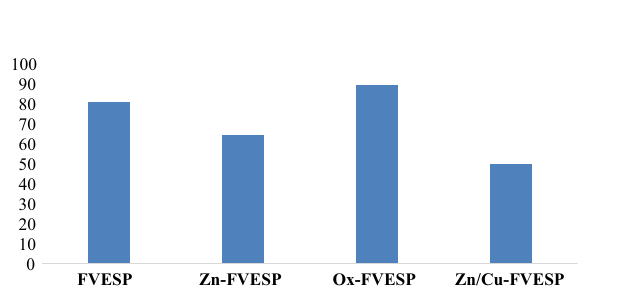
Table 1. BET surface analyzer of FVESP, Ox-FVESP, Zn-FVESP, and Zn/Cu-FVESP.